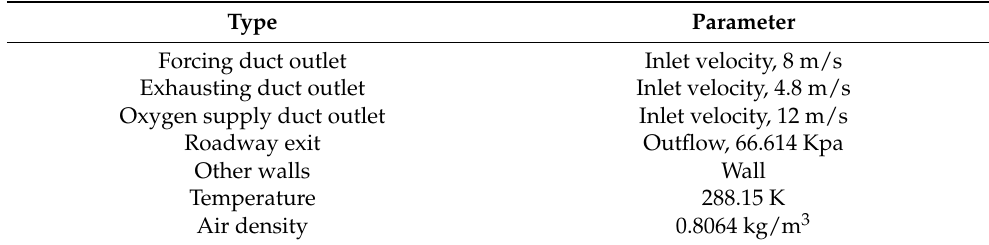
Table 2. Boundary conditions. Type Parameter Forcing duct outlet Inlet velocity, 8